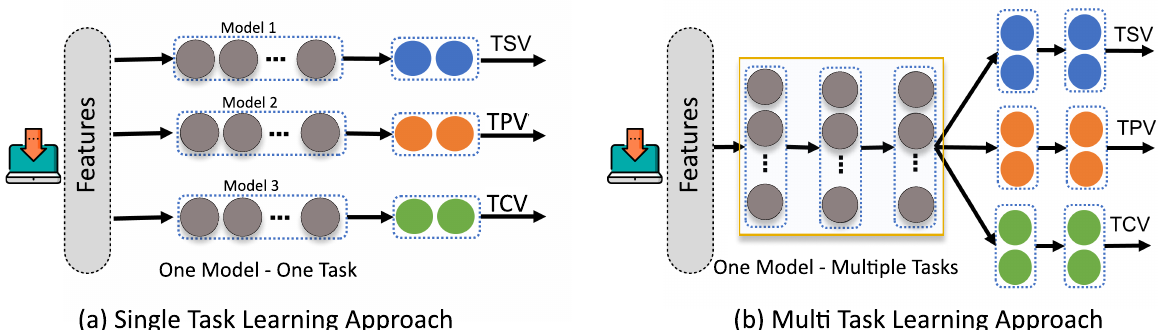
Figure 15. Single task vs. Multi-task